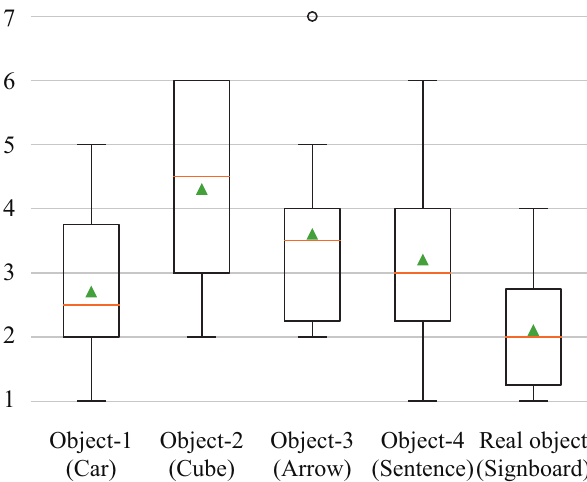
Figure 10. The result of Question-C: Did you feel that it was difficult to walk because of the object?